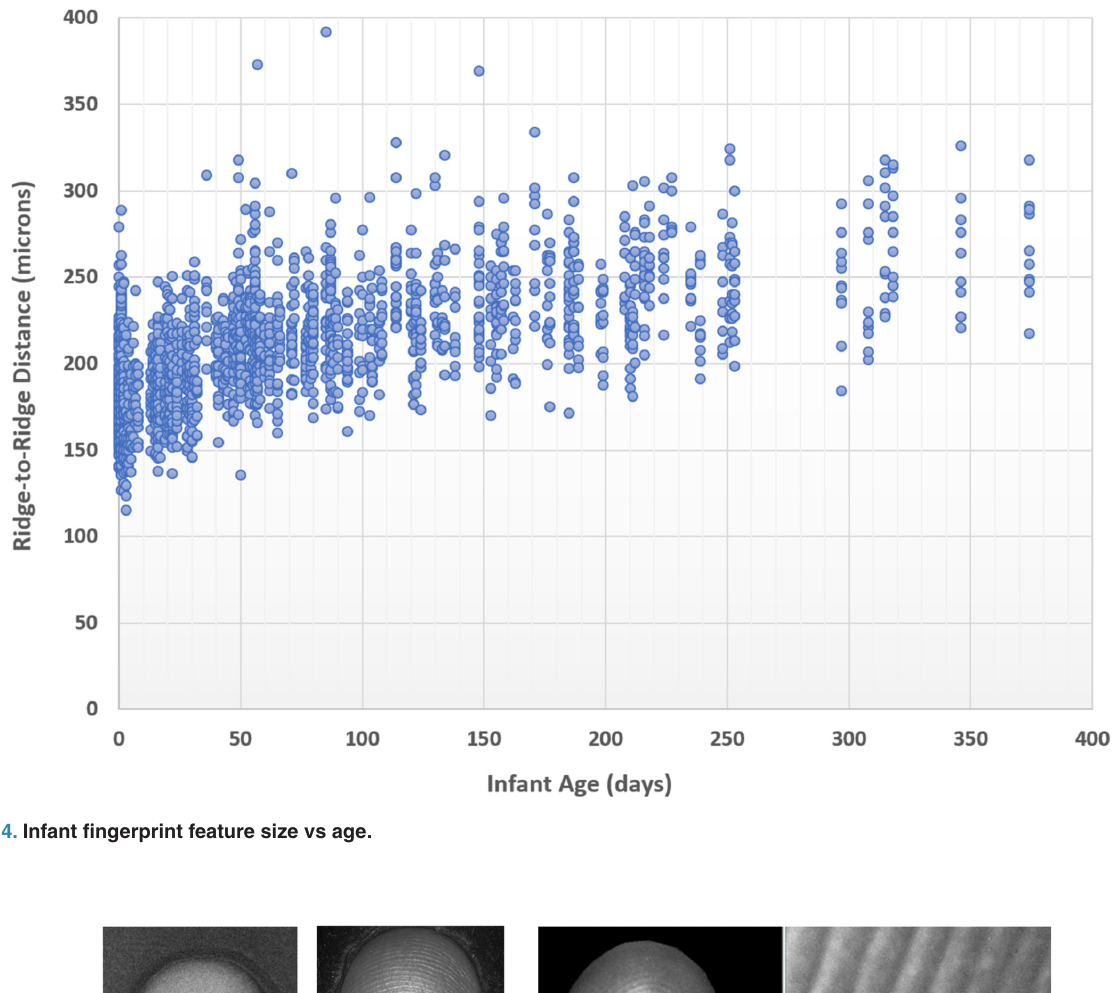
Figure 4. Infant fingerprint feature size vs age.